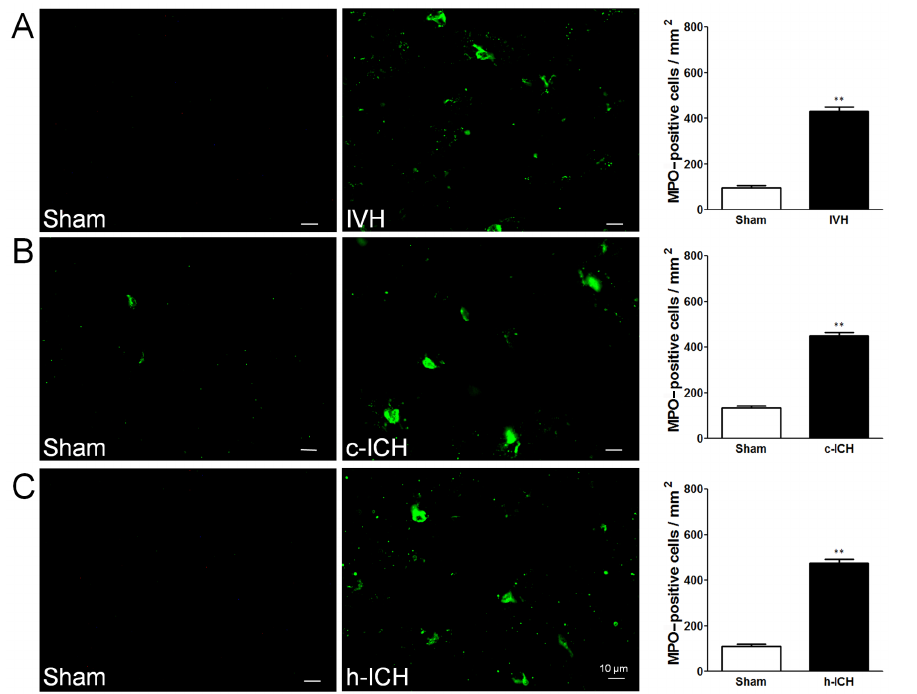
Figure 5. Neutrophil infiltration is elevated 72 h after intracerebral hemorrhage (ICH) in ventricle, cortex, and hippocampus. Staining for myeloperoxidase (MPO) revealed neutrophil infiltration in the brain regions around the lateral ventricles 72 h after intraventricular hemorrhage (IVH; A) and in the perihematomal regions of the frontal cortex (B) and hippocampus (C) 72 h after cerebral ICH (c-ICH) and hippocampal ICH (h-ICH), respectively. Quantification analysis showed that the number of MPO-positive cells in the IVH, c-ICH, and h-ICH groups was significantly greater than that in the respective sham groups (n=5 mice per group). Scale bar = 10 m m. Values are means 6 SD; ** p , 0.01, t-test.